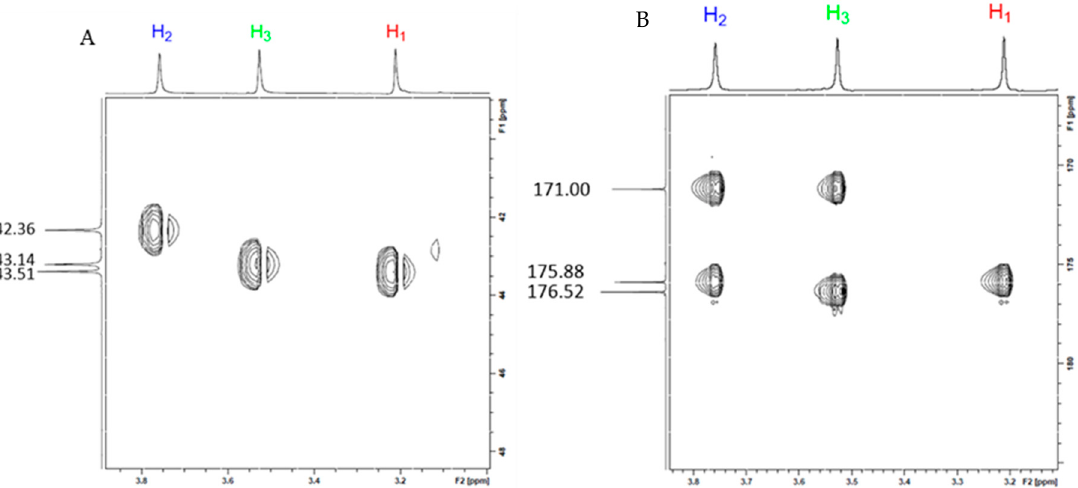
Figure 5. 2D HSQC of MgG 3 ( A ) showing the same observable nuclei points that were observed for the free HG 3 ligand and the HMBC of MgG 3 ( B ) indicating a change in the observable nuclei pattern; the observable nuclei now show a 2:2:1 pattern, which indicates that the H 1 proton is now the most upfield shifted proton. Full spectra available in Supplemental Figure S11.